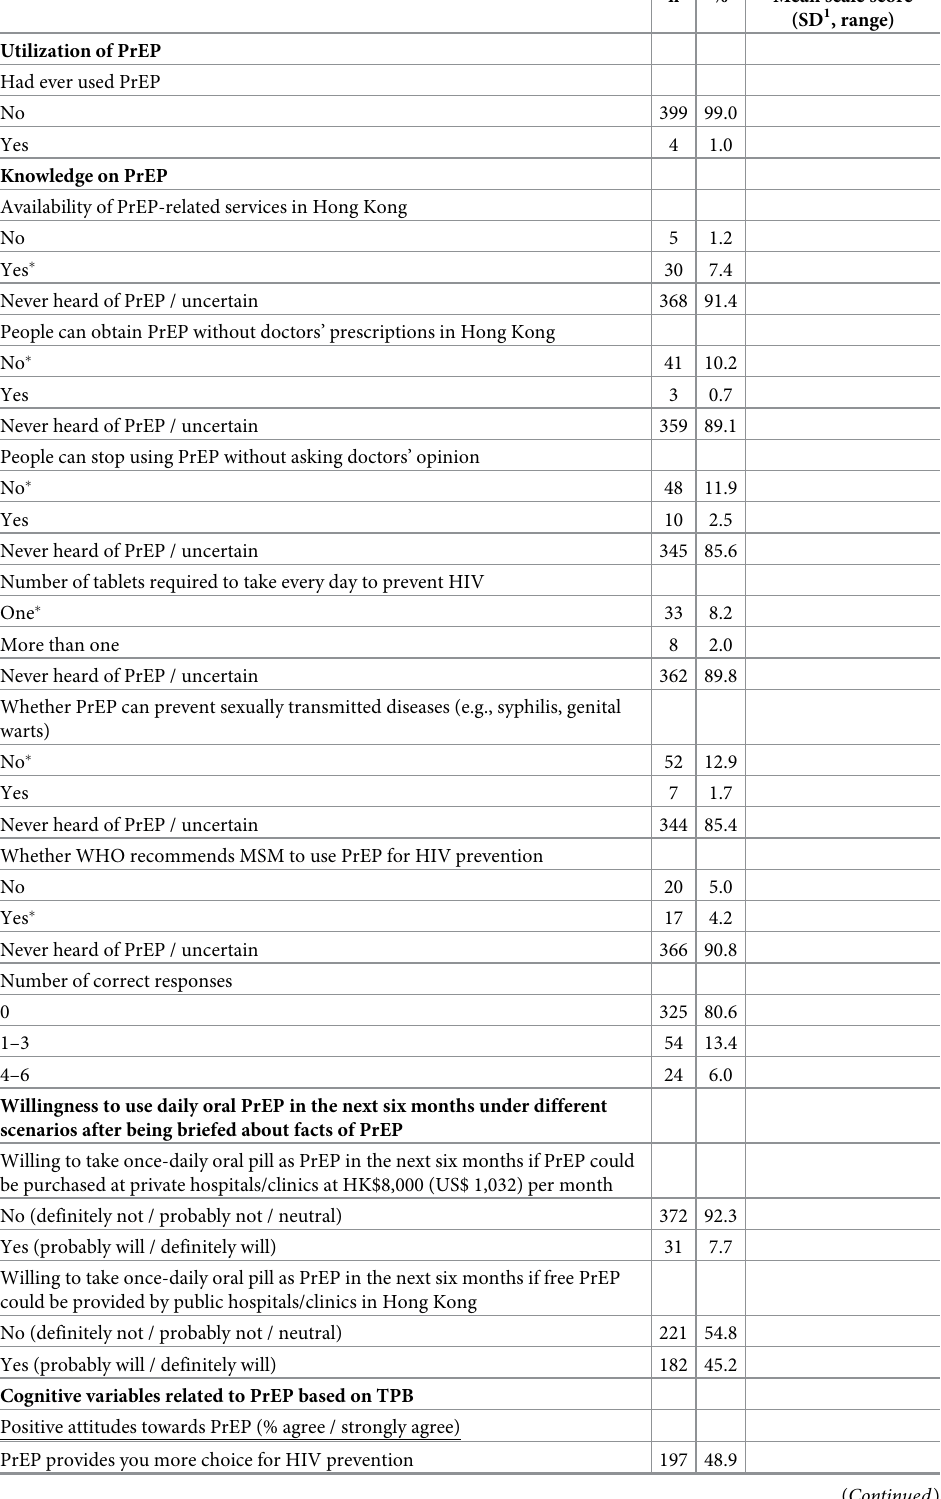
n % Mean scale score (SD 1 ,